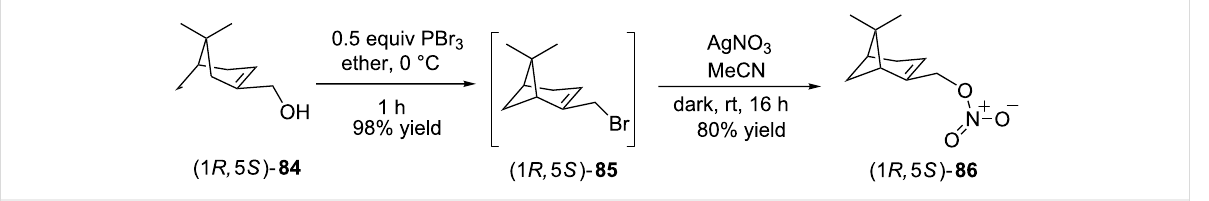
Scheme 14: Synthesis of monoterpene derived (1 R ,5 S )-( − )-myrtenol nitrate 86